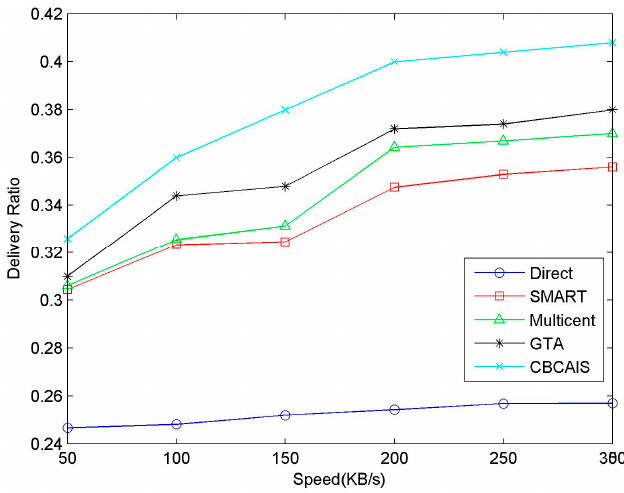
Figure 21. Delivery ratio for varying transmission speeds.